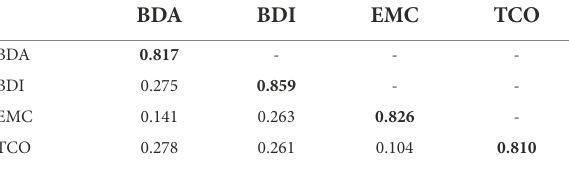
TABLE 3 Discriminant validity (Fornell Larcker).